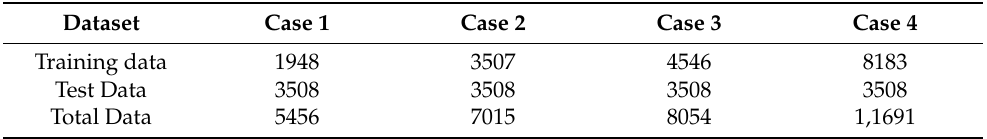
Table 4. Case scenarios of the